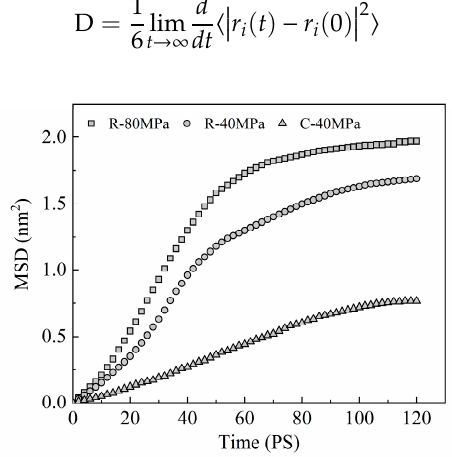
Figure 8. The mean square displacement (MSD) curve of the long-chain PC system in the packing stage.